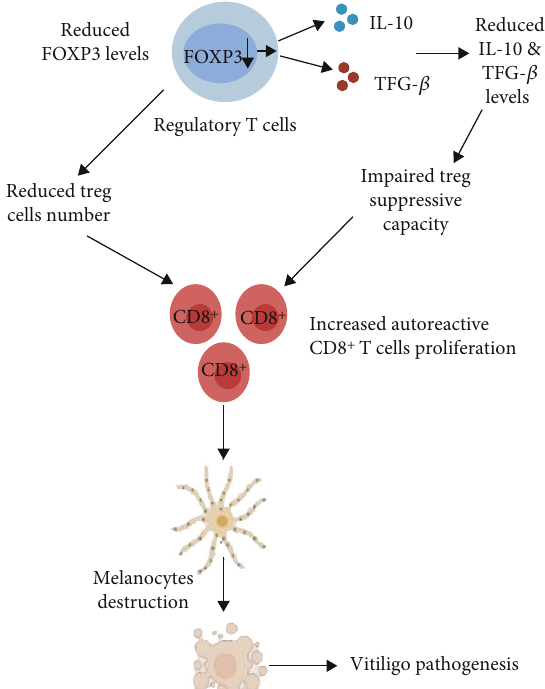
Figure 6: Role of regulatory T cells in vitiligo pathogenesis. The reduced expression of FOXP3, the key Tregs ’ transcription factors of Tregs, results in decreased expression of Tregs ’ suppressive cytokines (IL-10 and TGF- β ) and impaired Tregs ’ suppressive capacity. Moreover, the reduced FOXP3 levels in the blood suggests reduced Tregs ’ number in vitiligo patients. Thus, the decreased Tregs ’ frequency and impaired Tregs ’ suppressive capacity lead to unchecked CD8 + T proliferation, which results into melanocyte death and vitiligo